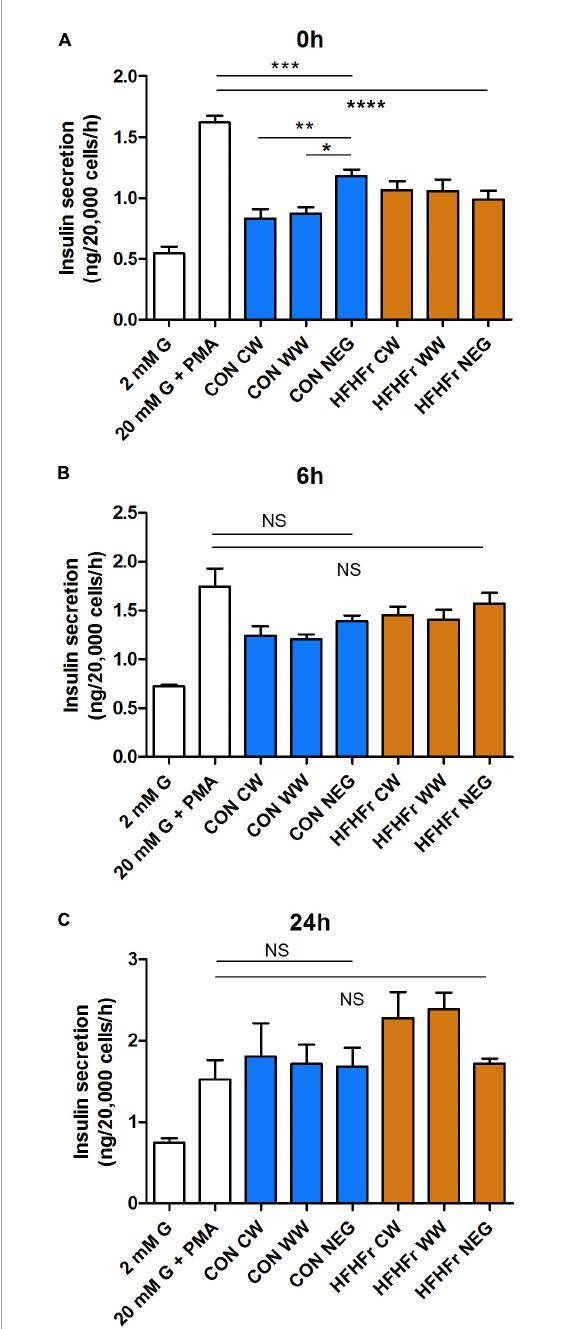
FIGURE8 Effect of a selected range of WW phenolic acids on insulin secretion from pancreatic MIN6 beta cells and islets. MIN6 cells (A,B) or islets (C) were stimulated with 2, 20 mM glucose (G) or 20 mM glucose + 10 µ M forskolin (FSK) + 100 µ M IBMX for 1 h with or without 100 nM (A,C) or 1 µ M (B) phenolic acids alone or combined (mix) as indicated. Data are expressed as mean ± SEM, (A) n = 7 from one experiment representative of 4–7, (B,C) n = 4. * P < 0.05, ** P < 0.01, *** P < 0.001 vs. 20 mM G control (A,B) or 2 mM G control (C) , one-way ANOVA and Bonferroni’s multiples comparison test. FA, ferulic acid; IFA, isoferulic acid; 3-OH-BA, 3-hydroxybenzoic acid; 4-OH-BA, 4-hydroxybenzoic acid; SA, salicylic acid; CA, caffeic